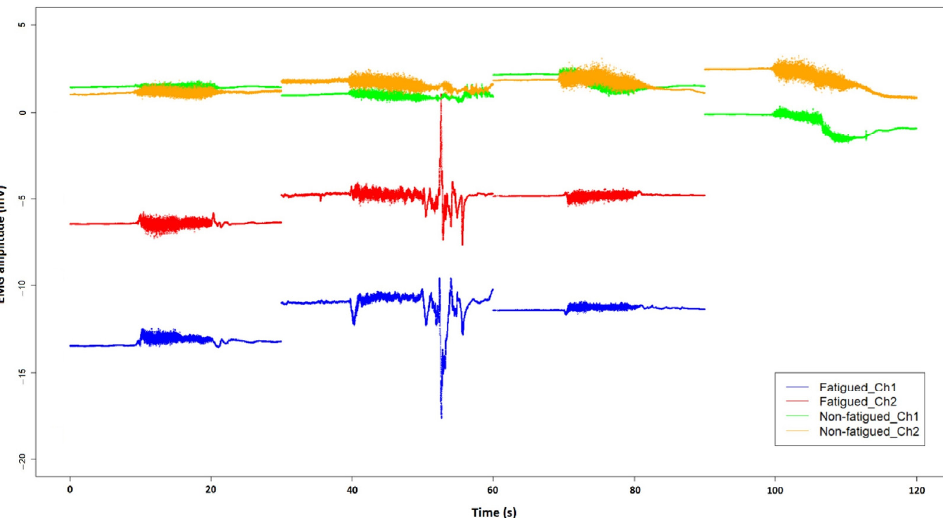
Figure 7. Surface EMG signals of the left vastus lateralis (shown as Ch1) and the left rectus femoris (shown as Ch2) of a fatigued participant, compared with those of a participant who did not report fatigue. An epoch of 30 s EMG signals is extracted for each 10 s prompted contraction of the thigh, together with 10 s before and after the muscle contraction. The fourth muscle squeeze for the fatigued participant was not performed due to early termination of the head-up tilt test.